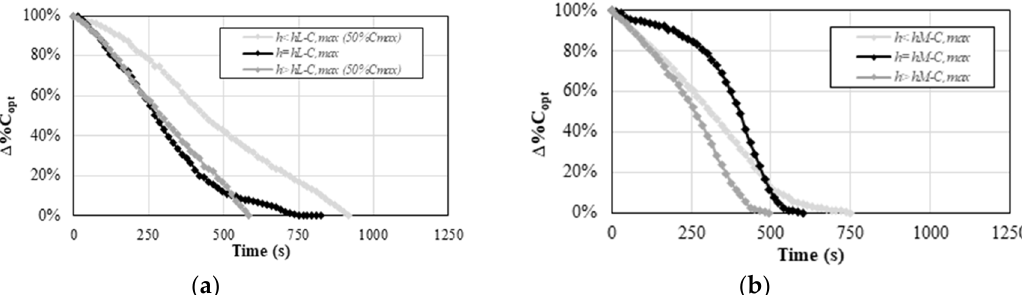
Figure 10. Percentual reduction over time of C opt for different values of h L − C and h M − C respectively in the case of Fresnel lens ( a ) and spherical mirror ( b ) in absence of secondary optics.